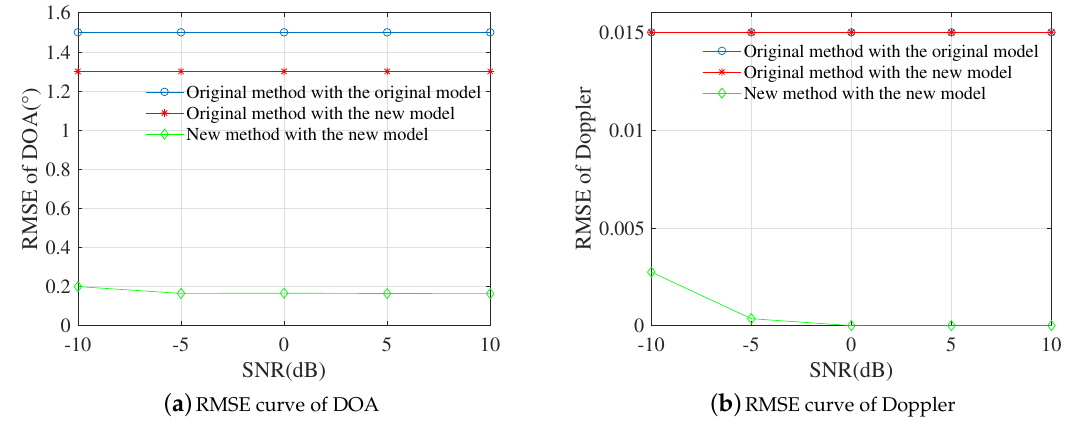
Figure 3. Root mean square error (RMSE) curves of DOA and Doppler versus SNRs.